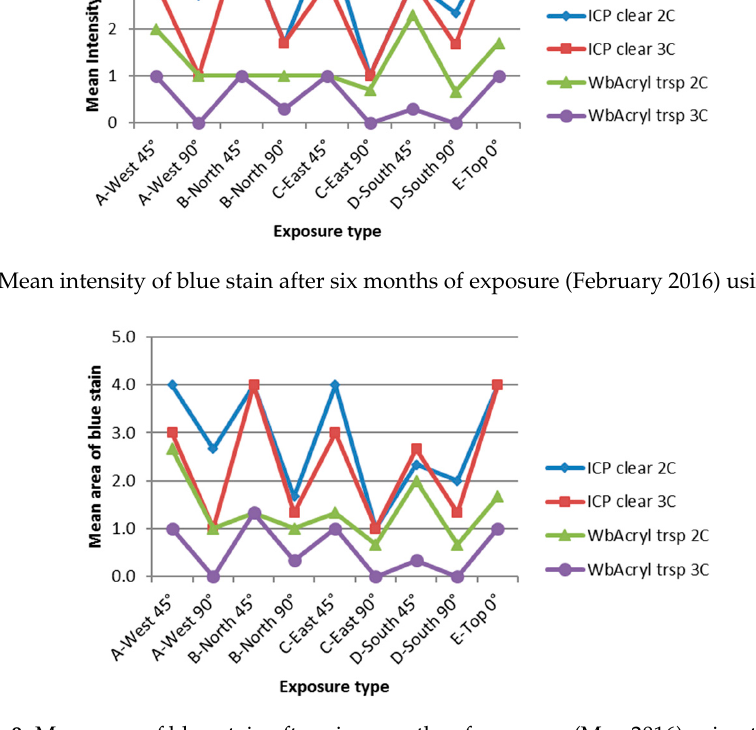
Figure 9. Mean area of blue stain after nine months of exposure (May 2016) using the MFER.